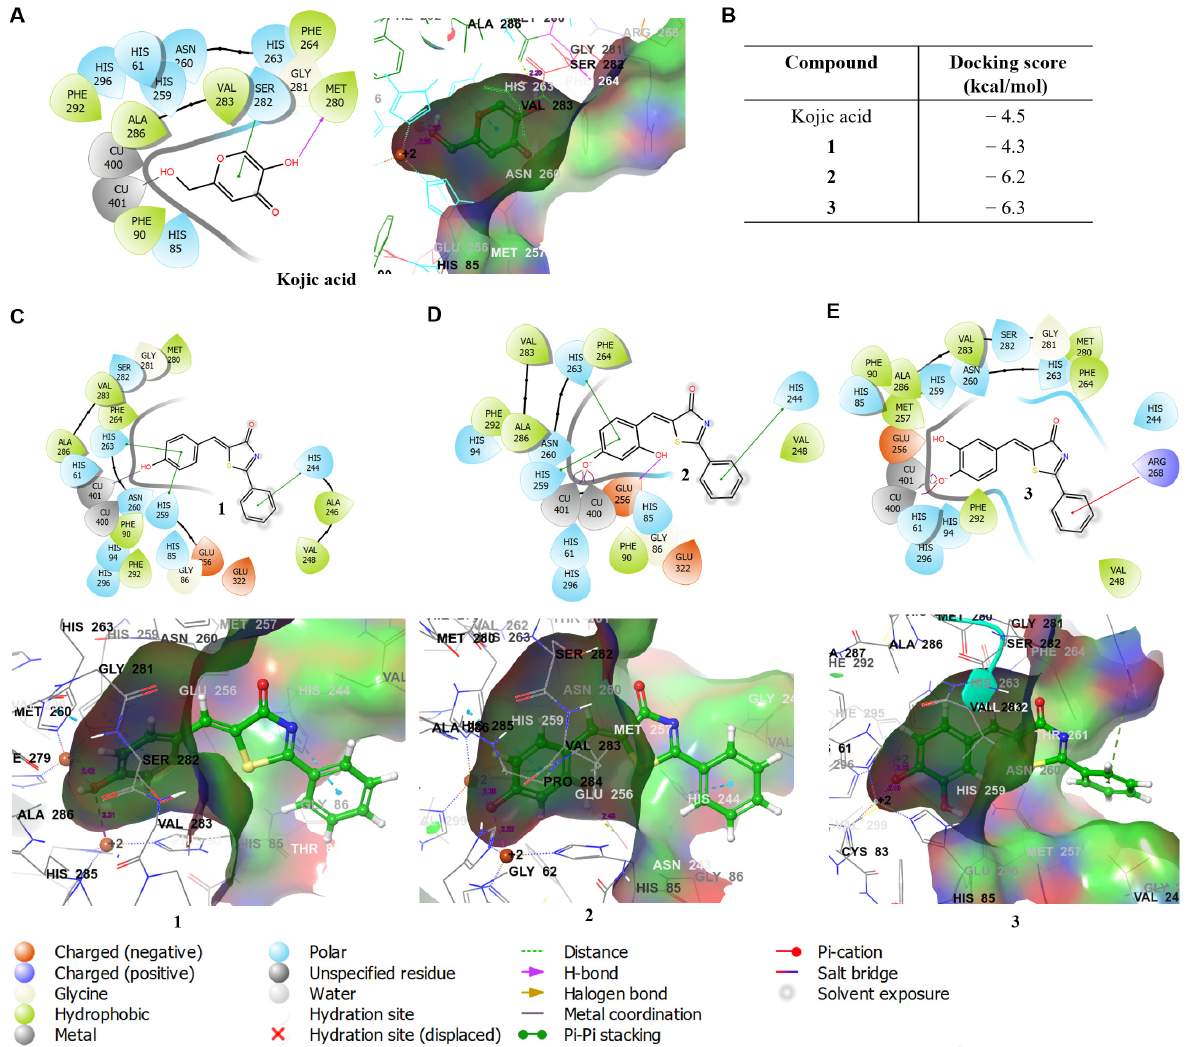
Figure 4. Docking scores and in silico docking simulation results of kojic acid, ( Z )-BPT derivatives 1 – 3 , and mushroom tyrosinase using Schrodinger Suite. ( A ) Kojic acid, ( B ) docking scores, ( C ) ( Z )-BPT derivative 1 , ( D ) ( Z )-BPT derivative 2 , and ( E ) ( Z )-BPT derivative 3 .